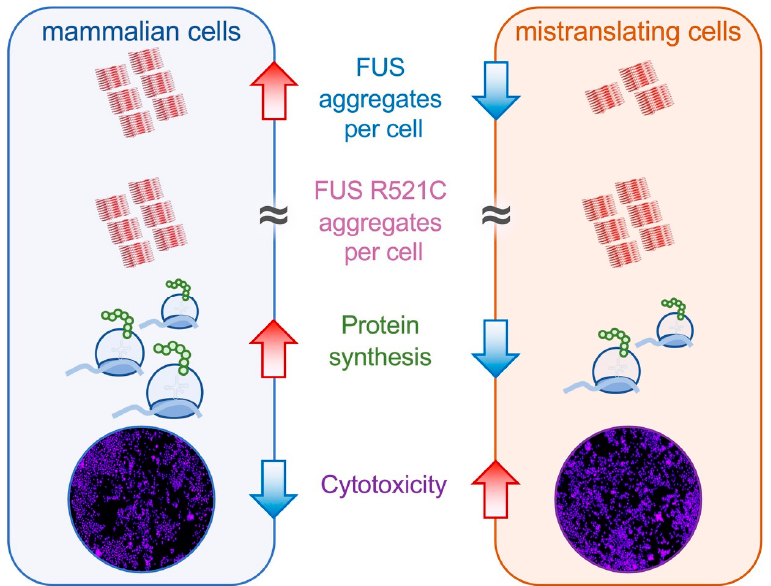
Figure 8. Schematic of FUS aggregation in normal and mistranslating N2a cells. The mistranslating tRNA Ser AAA reduces protein levels in cells. We found that FUS aggregation properties and kinetics were characteristically distinct in mistranslating cells. While the wild-type FUS protein showed reduced numbers of FUS aggregates per cell in mistranslating cells, the FUS R521C mutant aggregates were produced at similar numbers per cell in cells expressing wild-type and mistranslating tRNA. We also observed synthetic toxicity in the genetic interaction between the FUS R521C allele and the mistranslating tRNA Ser AAA